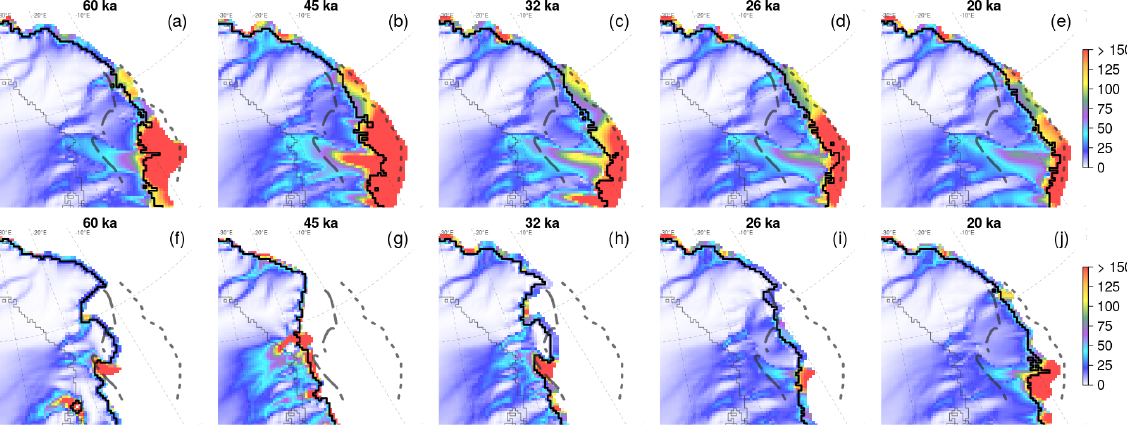
Figure 4. Snapshots of U (ma − 1 ) in total absence of submarine melting (a–e) and in the presence of active orbitally driven oceanic forcing ( κ = 8 ma − 1 K − 1 ; B ref = 8ma − 1 ) (f–j) at different times through MIS-3 and the LGM. The sector shown spans an area of about 600km by 600km. The black line represents the position of the simulated grounding line. The grey thin solid line represents the observed PD grounding- line position (Schaffer et al., 2016). Maximum (dotted black line) and minimum (dashed black line) grounding-line positions reconstructed for the LGM (Funder et al., 2011) are also shown.